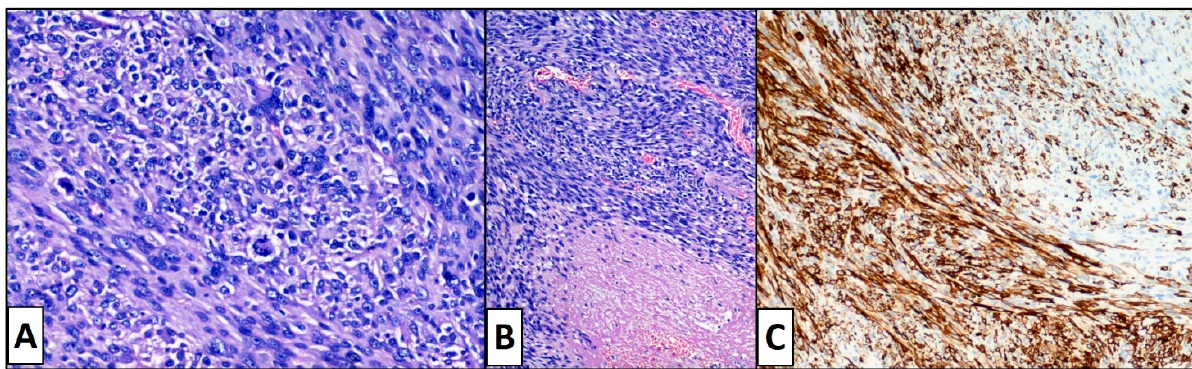
Figure 2. Histopathological features of the primary cutaneous leiomiosarcoma at low magnification.